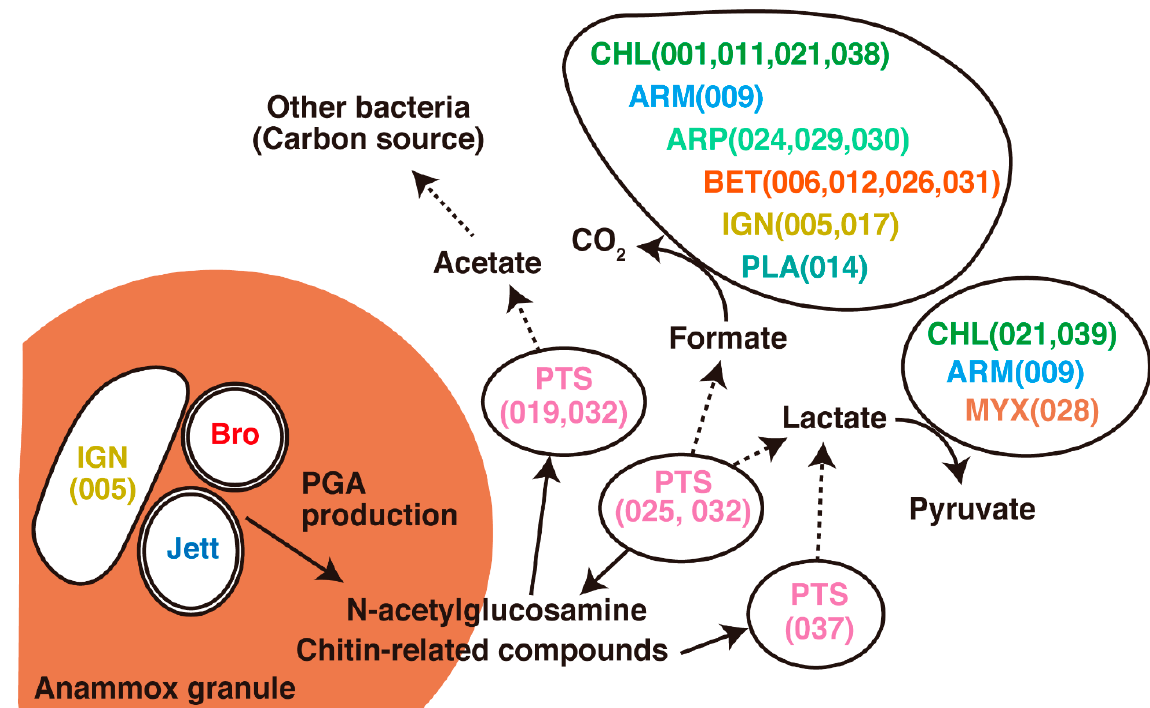
Figure 5. Putative carbon metabolic interactions among Patescibacteria and predominant bacteria. The numbers on the bacterial cells indicate the bin IDs shown in Table 1. PTS: Patescibacteria , IGN: Ignavibacteriae , Bro: Candidatus Brocadia, Jett: Candidatus Jettenia, CHL: Chloroflexi , ARM: Armatimonadetes , ARP: Alphaproteobacteria , BET: Betaproteobacteria , PLA: Planctomycetes , MYX: Myxococcales . Solid arrows indicate the degradation and metabolic flows of poly- N -acetylglucosamine/chitin-related compounds. Dashed arrows indicate the by-products from fermentation and poly- N -acetylglucosamine degradation. Curved solid arrows indicate metabolic reactions via formate or lactate dehydrogenases.